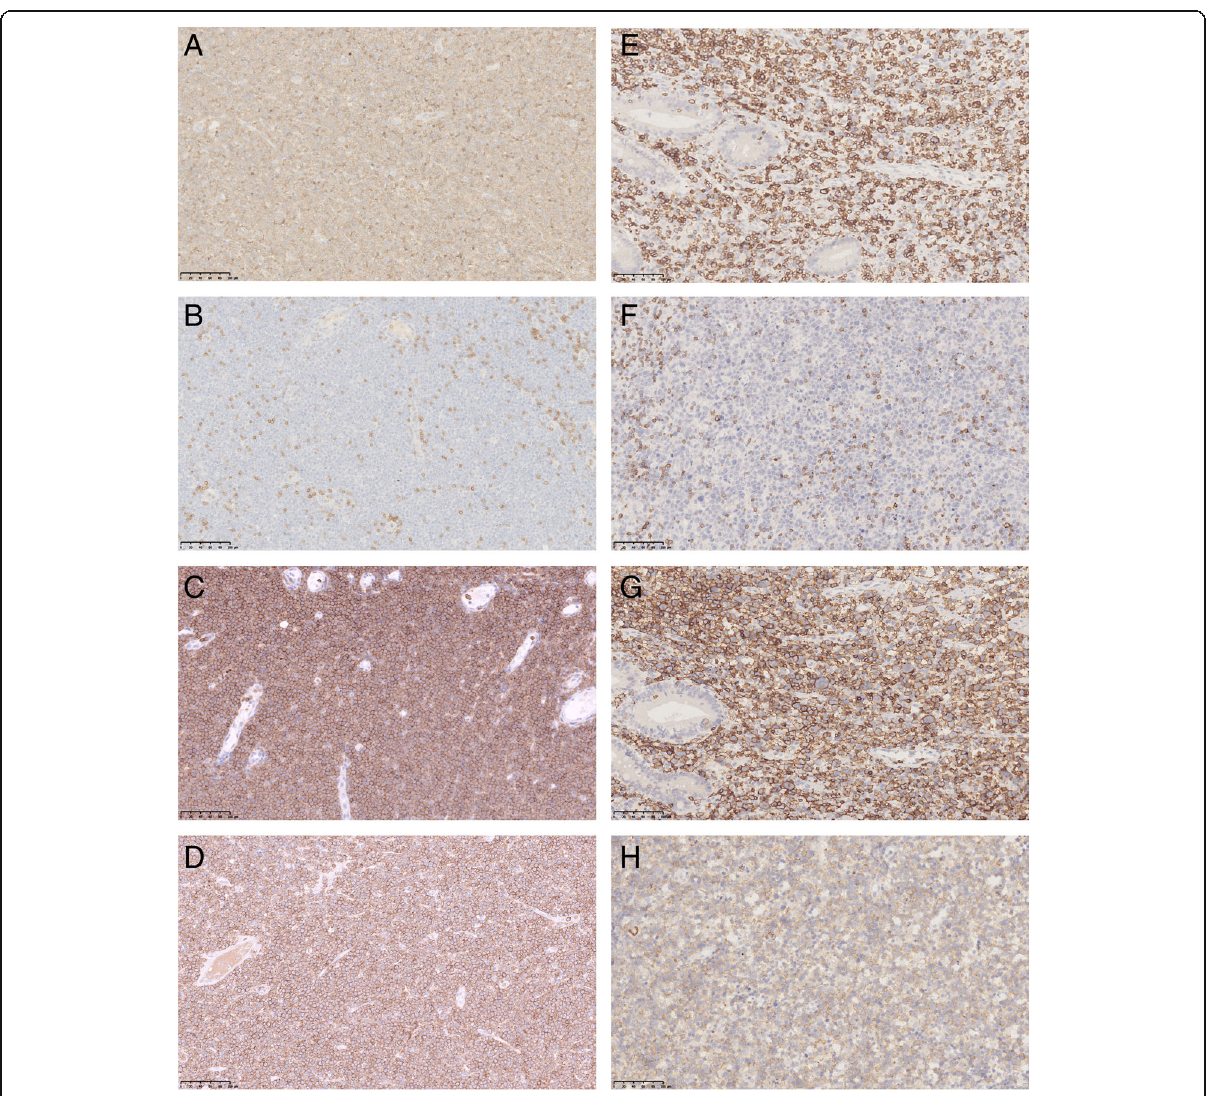
Fig. 2 The immunophenotypes of monomorphic epitheliotropic intestinal T ⁃ cell lymphoma. A-H: ×20. A-D: MEITL with diffuse monomorphic cells. E-H: MEITL with scattered pleomorphic cells. A, E CD3+; ( B, F ) CD5-; ( C, G ) CD8+; ( D, H )